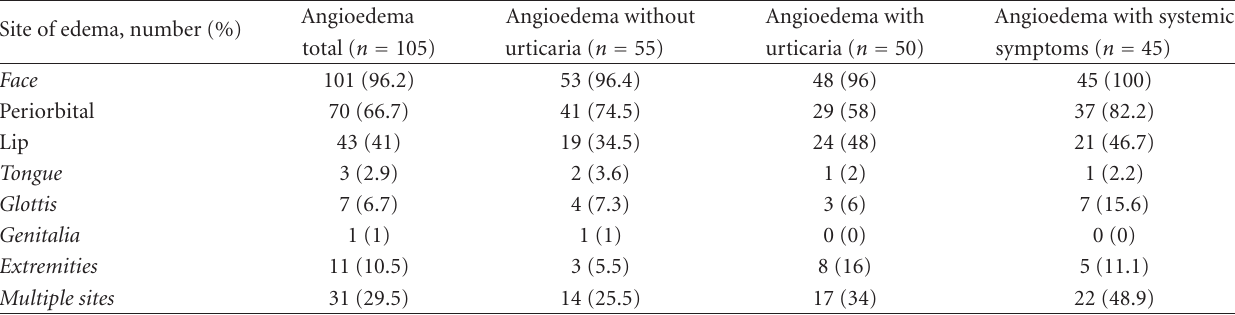
Table 3: Anatomic sites of involvement of angioedema.